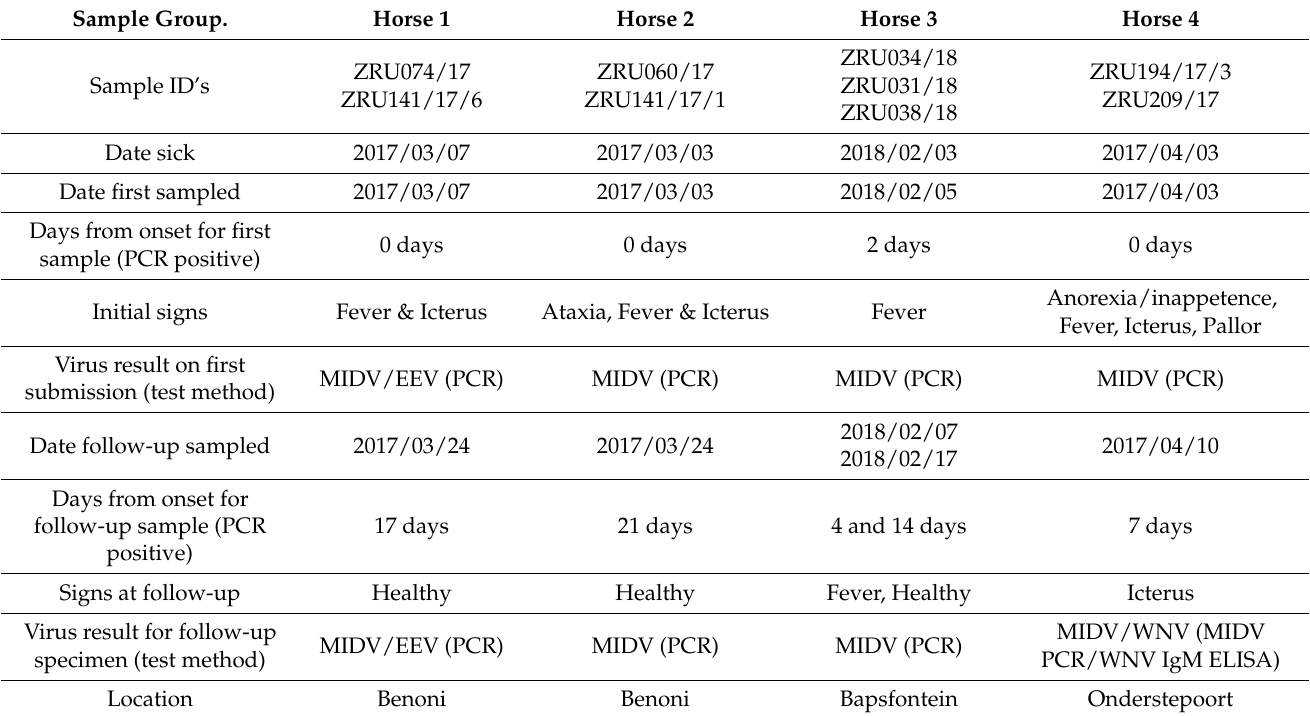
Table 4. Detection of MIDV in original and follow-up specimens from horses from South Africa between January 2014–December 2018 via real-time RT-PCR. Sample Group. Horse 1 Horse 2 Horse 3 Horse 4